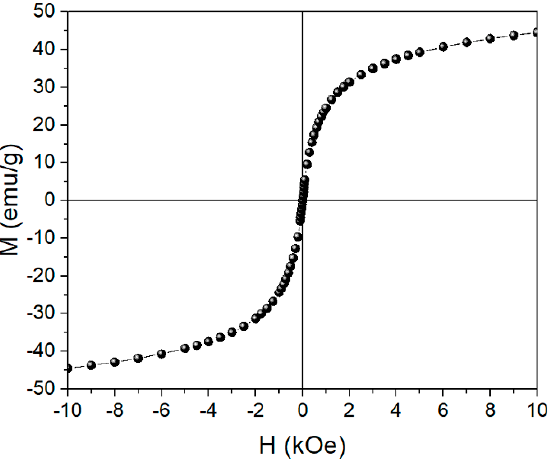
Figure 5. ( a , b ) TEM images of Fe 3 O 4 @CA MNPs; ( c ) corresponding NP size distribution from the TEM.